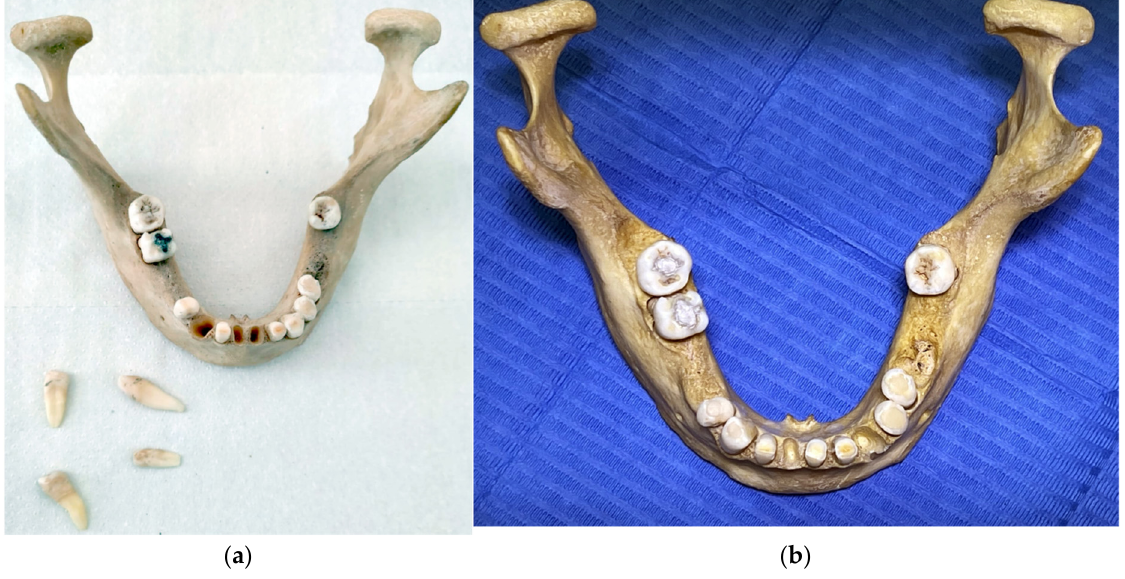
Figure 1. The human mandible with teeth: ( a ) before creating dental fillings; ( b ) after dental fillings and CBCT scan.